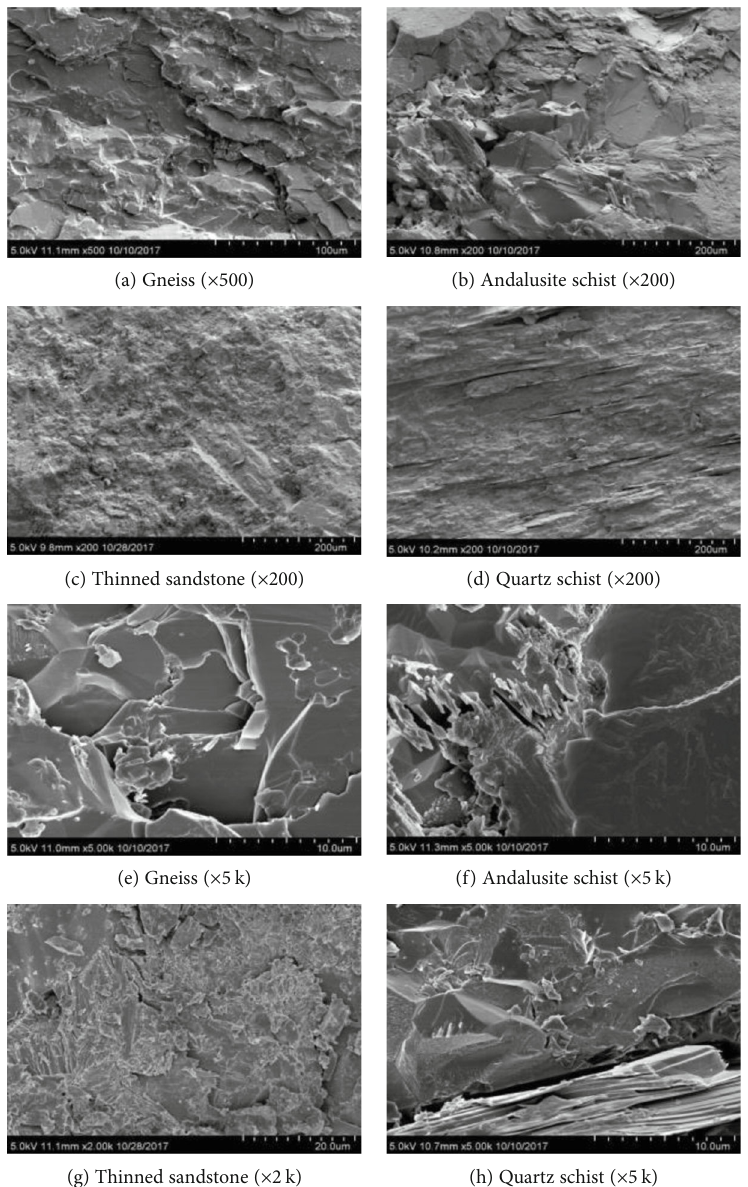
Figure 5: SEM images of di ff erent rock samples.